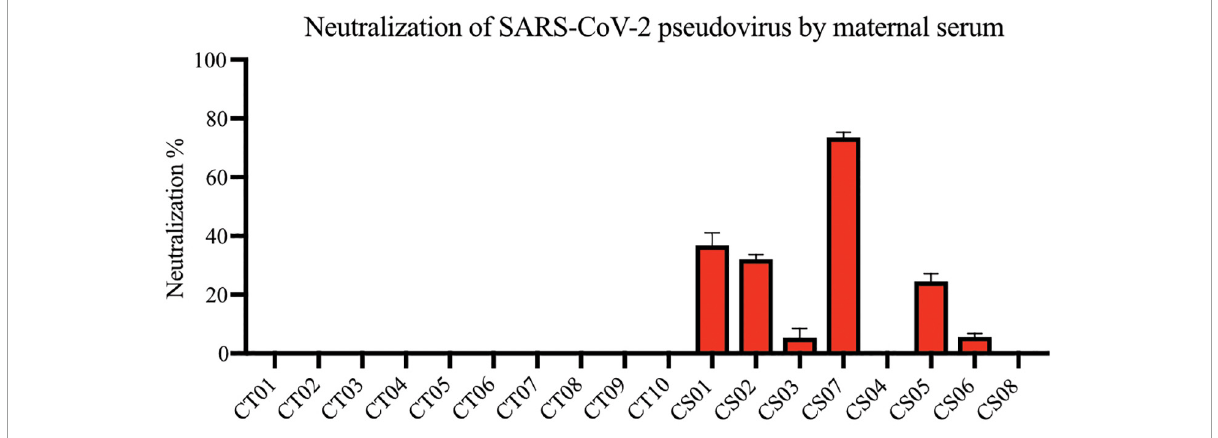
FIGURE3 Neutralization of SARS-CoV-2 pseudovirus using maternal plasma. Plasma from control ( n = 10) and convalescent mothers ( n = 7). Bar graphs represent the average percentage neutralization. Convalescent mothers (CS samples) are arranged in ascending order according to their time from COVID diagnosis to